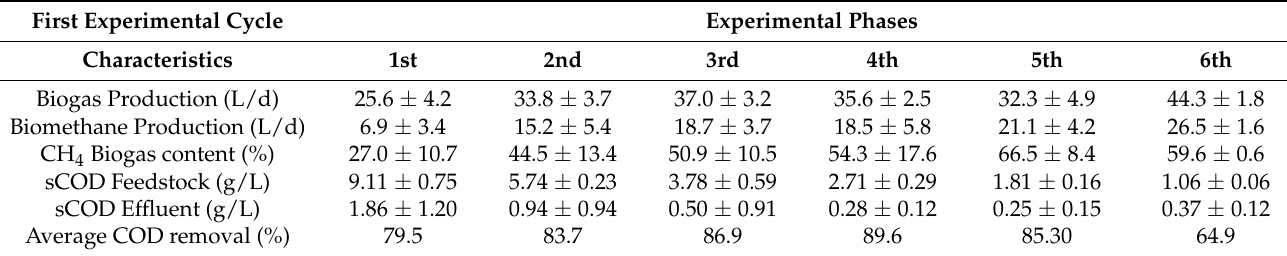
Table 3 . Average daily results of the first experimental cycle phases. Table 3. Average daily results of the first experimental cycle phases.